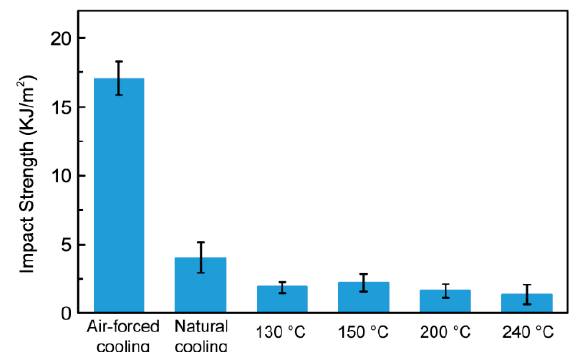
Figure 11. Izod notched impacted strength of 3D-printed PPS samples.